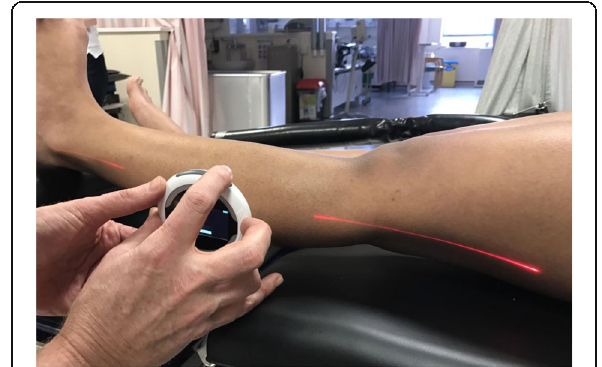
Fig. 4 Use of laser projection with Halo Digital